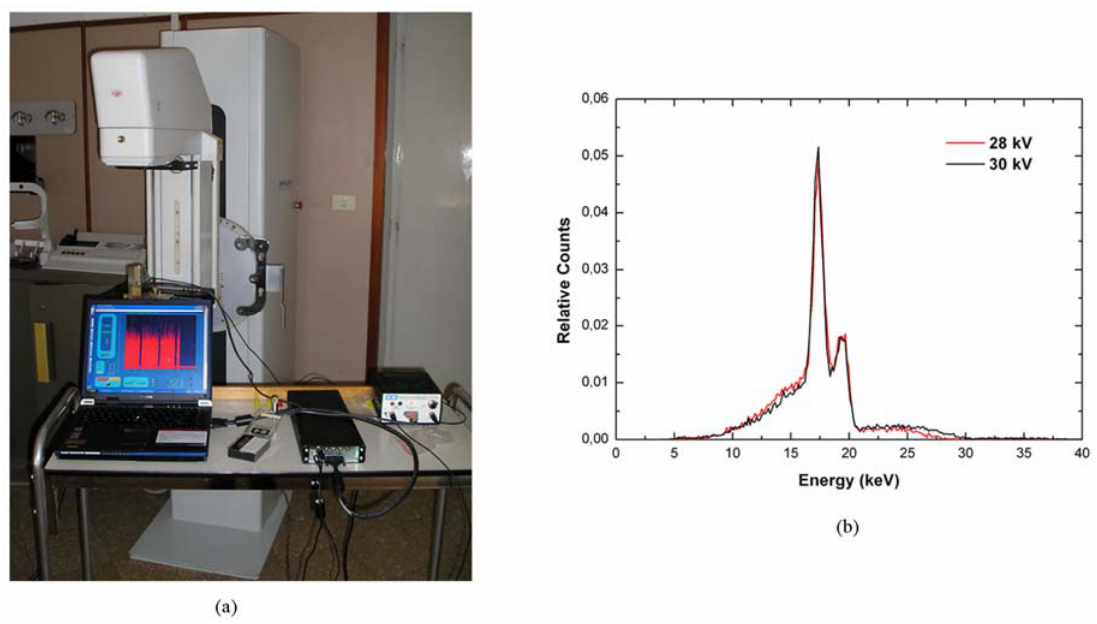
Figure 26. (a) Experimental set-up of direct measurements of mammographic spectra with a portable device based on a CdTe detector. (b) Mammographic X-ray spectra (Mo target) measured with a portable device, based on a CdTe detector, under clinical conditions